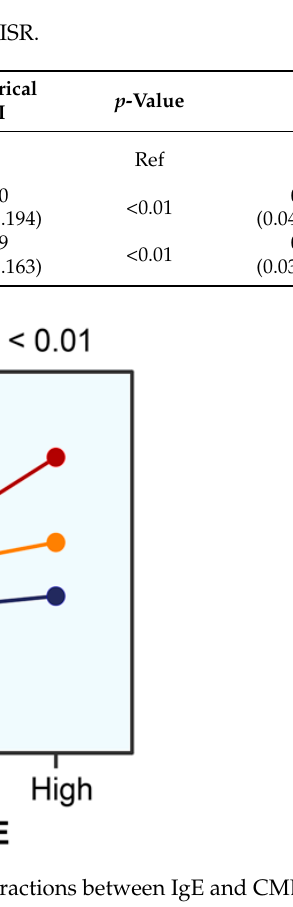
Table 4. The predictive power of models for ISR .